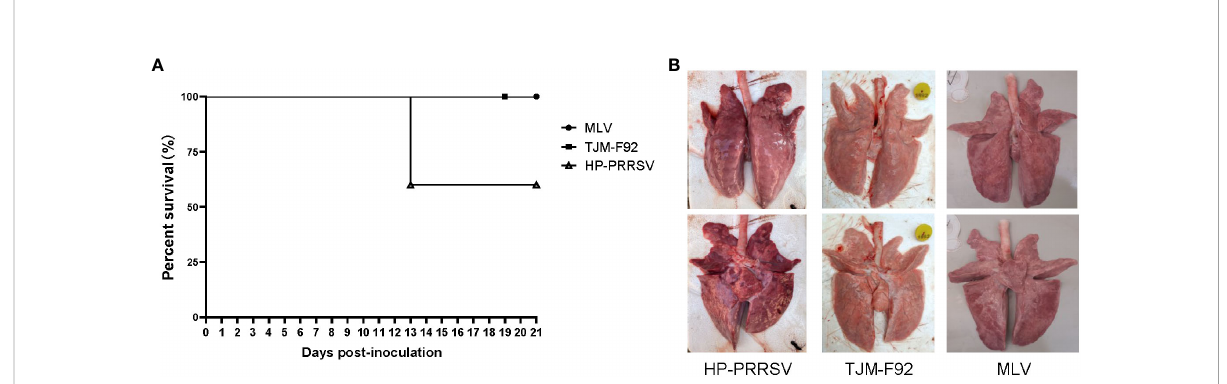
FIGURE 5 Infection of piglets using PRRSV strains with different virulence cannot induce pGM-CSF induction. (A) All piglets were inoculated with 1.0×10 5 TCID50 of HP-PRRSV-XJA1, or two vaccines strains (MLV and TJM-F92) via both intramuscular and intranasal routes. Clinical signs and survival rates were monitored daily for a total of 21 days. (B) Representative ventral and dorsal lung images from surviving piglets of each group were captured immediately after piglets were autopsied at 21